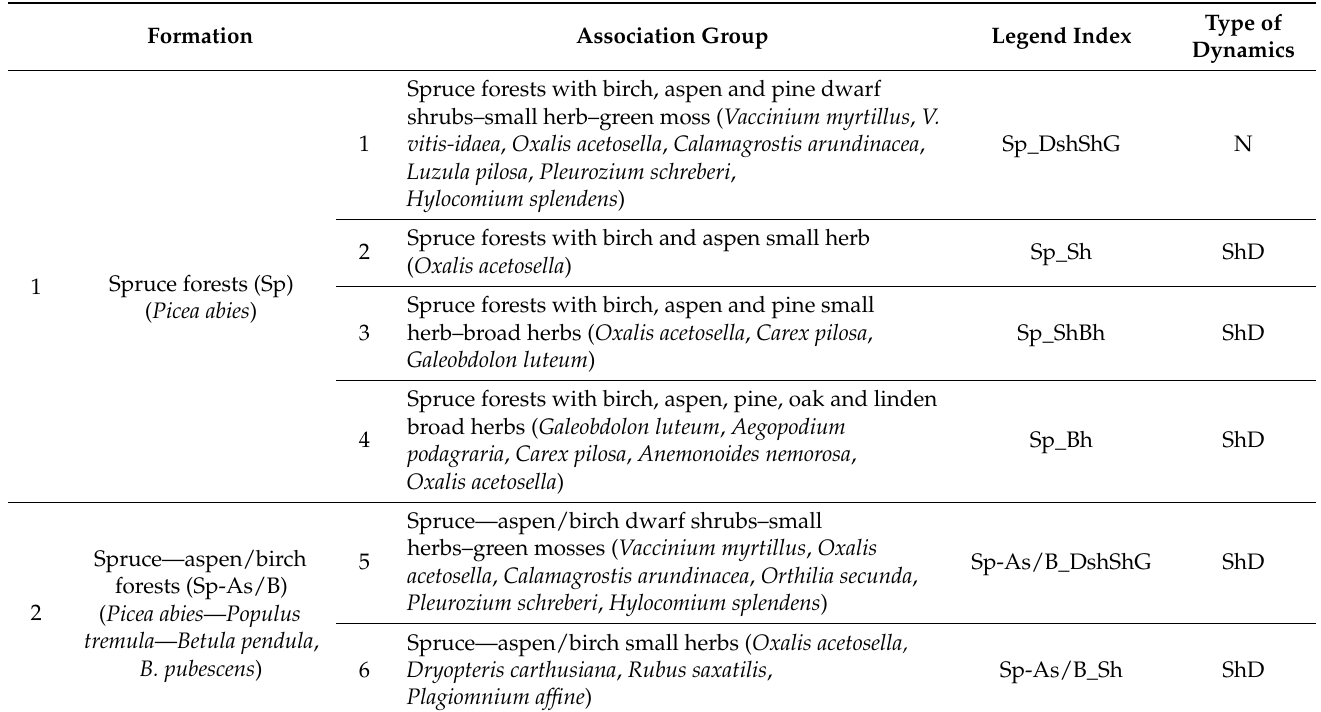
Table A3. Forest community